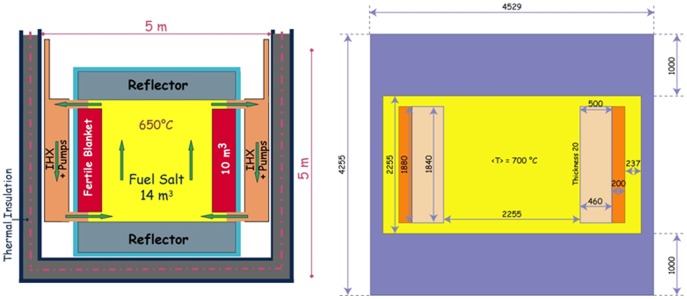
(Left): Simplified to scale vertical scheme of the MSFR system including the core, blanket and fuel heat exchangers (IHX) – (Right): Model of the core as used for the neutronic simulations with the fuel salt (yellow), the fertile salt (pink), the B4C protection (orange) and the reflectors and 20 mm thick walls in Ni-based allow (blue)[12].